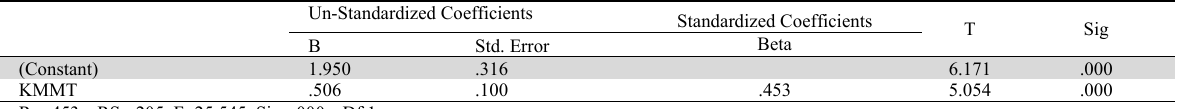
Results of the Multiple Regression Analysis of KM Mechanisms and Technologies in the Company´s Innovation Process and Products